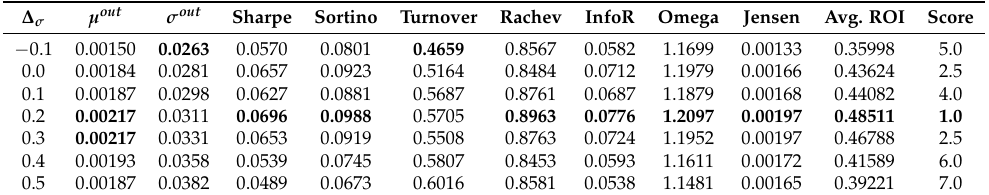
Table 2. ES50: out-of-sample performance results for the RMZ R strategy by varying ∆ σ (with ∆ γ = 1.7).